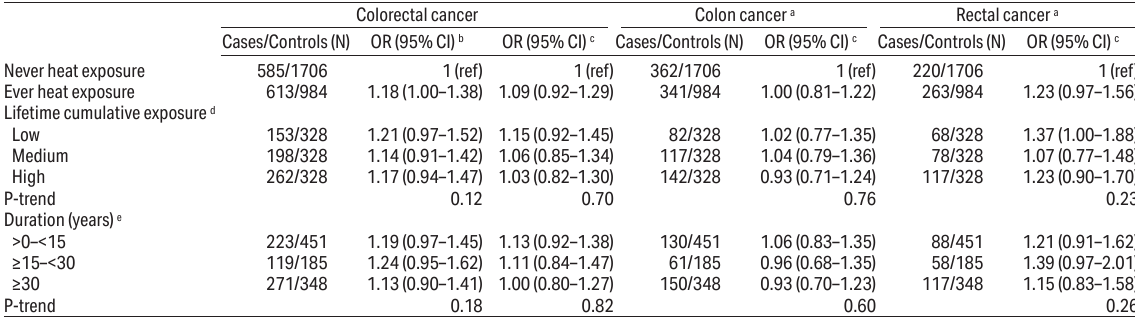
Table 2. Associations between occupational heat exposure and colorectal cancer [OR=odds ratio; CI=confidence interval]